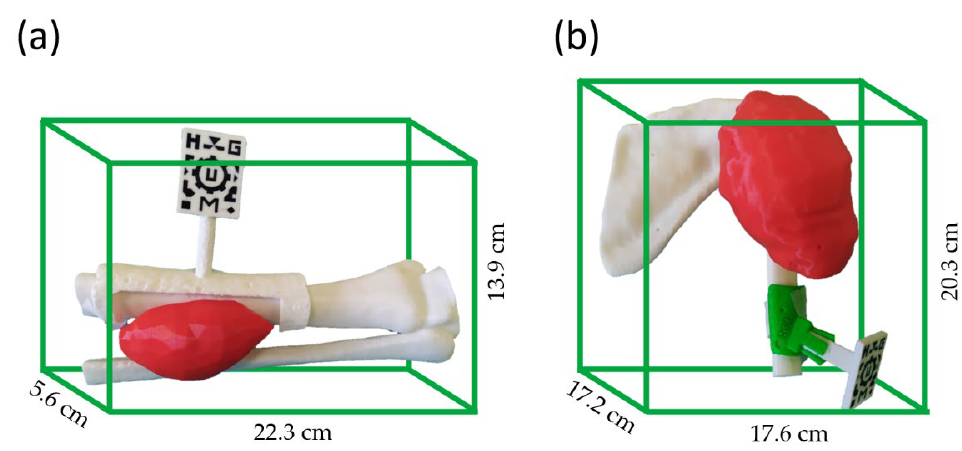
Figure 1. Diagram of the workflow presented in [21] to develop a patient phantom and a surgical guide.